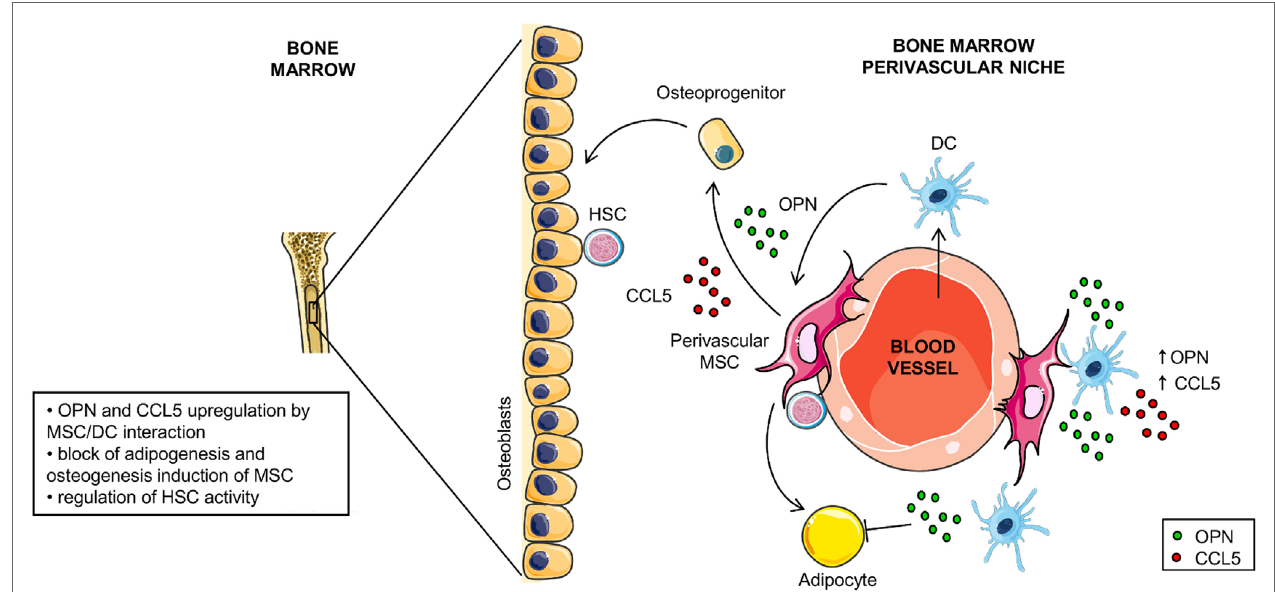
FigUre 7 | Hypothetical model for osteopontin (OPN) production in dendritic cell (DC)/mesenchymal stromal cells (MSC) cross-talk. In the perivascular area of the hematopoietic niche, DC/MSC interaction results in upregulation of OPN and CCL5 that influences the balance between osteogenesis and adipogenesis of